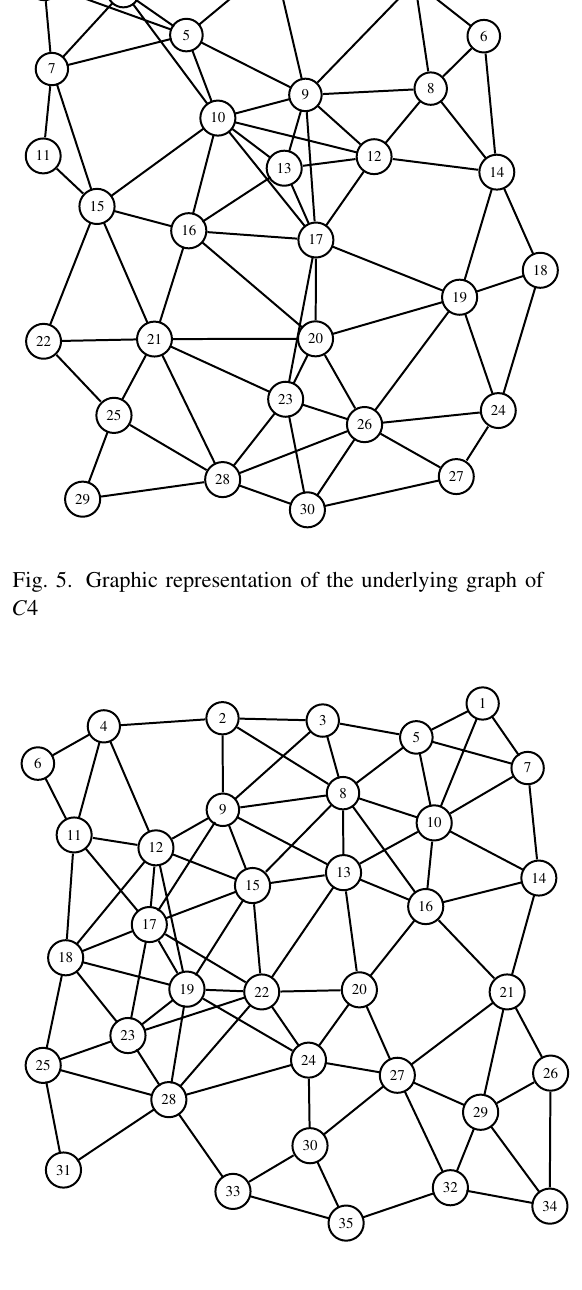
Fig. 6. Graphic representation of the underlying graph of C 5 For each θ ∈ Θ , the procedure we have utilized for generating the survey answers { α w ( θ ) } w ∈ W